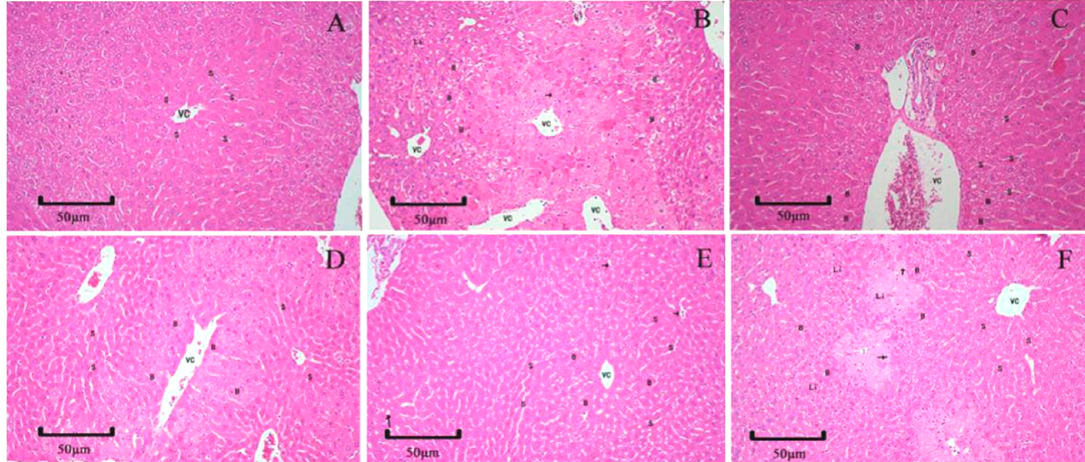
Figure 5. E ff ects of POPEP-III on CCl 4 -induced liver histopathological changes in mice ( × 20 H&E Figure 5. Effects of POPEP-III on CCl 4 -induced liver histopathological changes in mice (×20 H&E staining): ( A ) Normal group. ( B ) CCl 4 only group (240 µ L / kg.bw). ( C ) Positive group (200 mg / staining): ( A ) Normal group. ( B ) CCl 4 only group (240 µL/kg.bw). ( C ) Positive group (200 mg/kg.bw). ( D ) POPEP-III + CCl 4 (100 mg/kg.bw). ( E ) POPEP-III + CCl 4 (200 mg/kg.bw). ( F ) POPE +